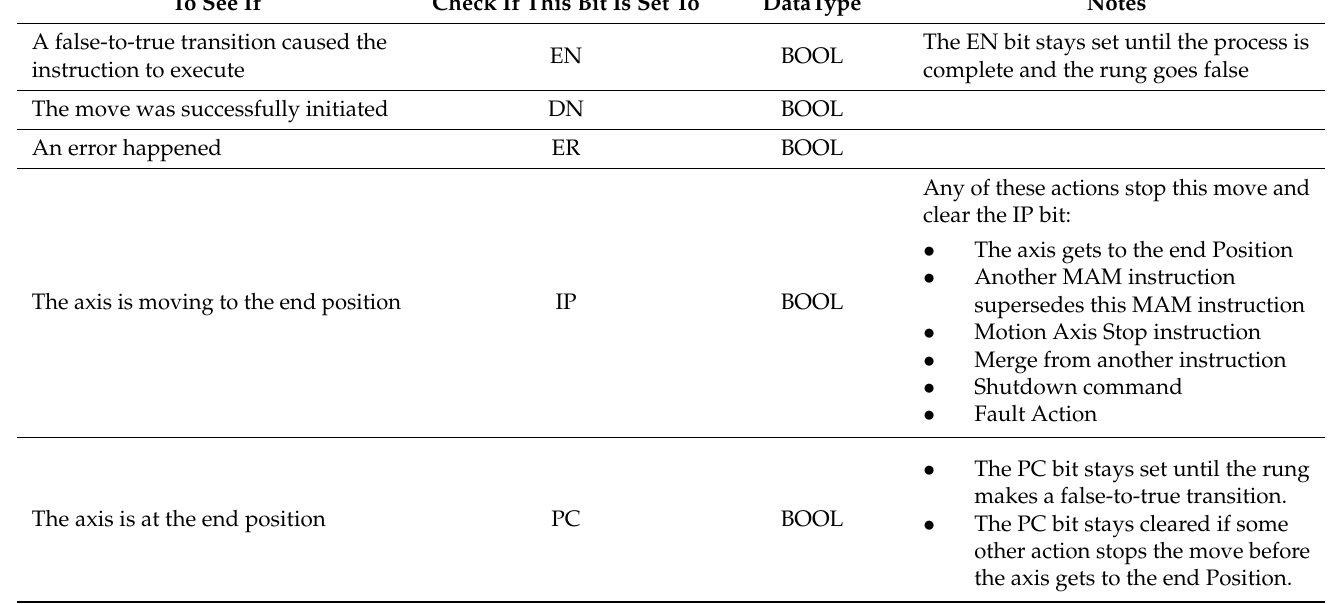
Figure 9. Sample StateFlow logic used to set position value to 90°. The objective of this work was to show that the control logic developed in the MBD environment could interact with standard PLC programming functions to perform an operation. It should be noted here that, although 0° and 360° physically occupy the same